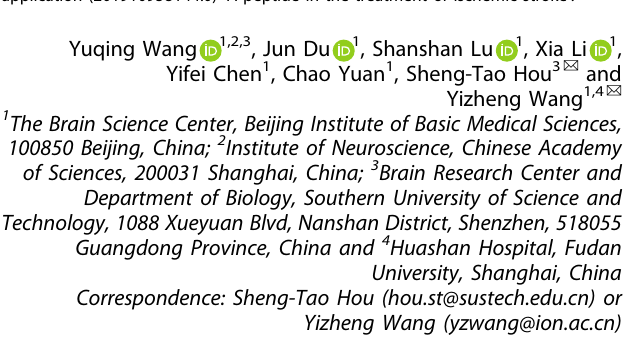
Fig. 1 PKC α binds to GLT-1 and phosphorylates it on Ser563 to inhibit its activities during ischemia. a Representative Coomassie blue staining image of the immunoprecipitated proteins from mice brain homogenate by GLT-1 antibody. The rectangle indicated the band used for mass spectrum analysis. The mass spectrum result was summarized in Supplementary Table S1, GLT-1 and PKC α were highlighted in red color. b Representative immunoblots of the precipitates by GST pull down to show the interaction between PKC α and GLT-1, bait protein: GST- PKC α , prey protein: HA-GLT-1. c A diagram showing the sequence of the indicated peptides. Phosphorylated serine was indicated by red color. d Upper: representative immunoblots of the four peptides indicated in the fi gure incubated with AP-563. Lower: representative Coomassie blue staining image of the four peptides. e Representative immunoblots of the 1 h in vitro phosphorylation system with the indicated antibodies. f Left: representative immunoblots of the immunoprecipitate from astrocytes incubated with His-SC-TAT or His-2A-TAT by the indicated antibodies. Right: statistics, n = 4. g Aspartate (Asp)-evoked GLT-1 currents in cultured astrocytes incubated with the indicated drugs for 30 min, n > 10 in each condition. Left, representative traces; Right, statistics. h , i Upper: representative immunoblots of the hippocampus lysate from contralateral or ipsilateral 30 min after MCAO with the indicated antibodies. Lower: statistics, n = 4. j Upper: representative immunoblots of the total, cytosol and membrane fractions of hippocampus taken from mice suffered for 1 h MCAO with His-SC-TAT or His-2A- TAT given 1 h before MCAO. Lower: statistics, n = 4. k Microdialysis and HPLC analysis of extracellular glutamate in the hippocampus during 2 h MCAO and 2 h reperfusion. His-SC-TAT or His-2A-TAT was given 1 h before MCAO, n = 4 in Sham group, n = 3 in His-SC-TAT group and n = 4 in His-2A-TAT group. l Left: representative TTC staining of brain slices from mice subjected to 2 h MCAO and 24 h reperfusion. His-SC-TAT or His-2A-TAT was given 1 h before MCAO. Right: statistics, n = 5 in sham group, n = 10 in His-SC-TAT group and n = 9 in His-2A-TAT group. m Left: representative immunoblots of the immunoprecipitate from astrocytes incubated with the indicated agents by the indicated antibodies. Right: statistics, n = 3. n Aspartate (Asp)-evoked GLT-1 currents in cultured astrocytes incubated with the indicated drugs for 30 min, n > 9 in each condition. Left, representative traces; Right, statistics. o Microdialysis and HPLC analysis of extracellular glutamate in the hippocampus during 2 h MCAO and 2 h reperfusion. Placebo or LXS-196 was given 45 min after MCAO, n = 4 in Sham group, n = 3 in Placebo group and n = 3 in LXS-196 group. p Left: representative TTC staining of brain slices from mice subjected to 2 h MCAO and 24 h reperfusion. Placebo or LXS-196 was given 30 min after MCAO. Right: statistics, n = 5 in sham group, n = 6 in placebo group and n = 7 in LXS-196 group. q Evaluation of survival rate during the following four weeks after MCAO. LXS-196 or placebo was given 30 min after MCAO. n = 5 in sham group, n = 13 in placebo group and n = 14 in LXS-196 group. Data are means ± SEM, ns, no signi fi cance. * p < 0.05, ** p < 0.01 and *** p < 0.001 by two-tailed Student ’ s t test in ( f – j) , by two-way ANOVA with Bonferroni ’ s multiple comparisons in ( k ) and ( o ), by one-way ANOVA with Bonferroni ’ s multiple comparisons in ( l – n ) and ( p ) and by log-rank test in ( q